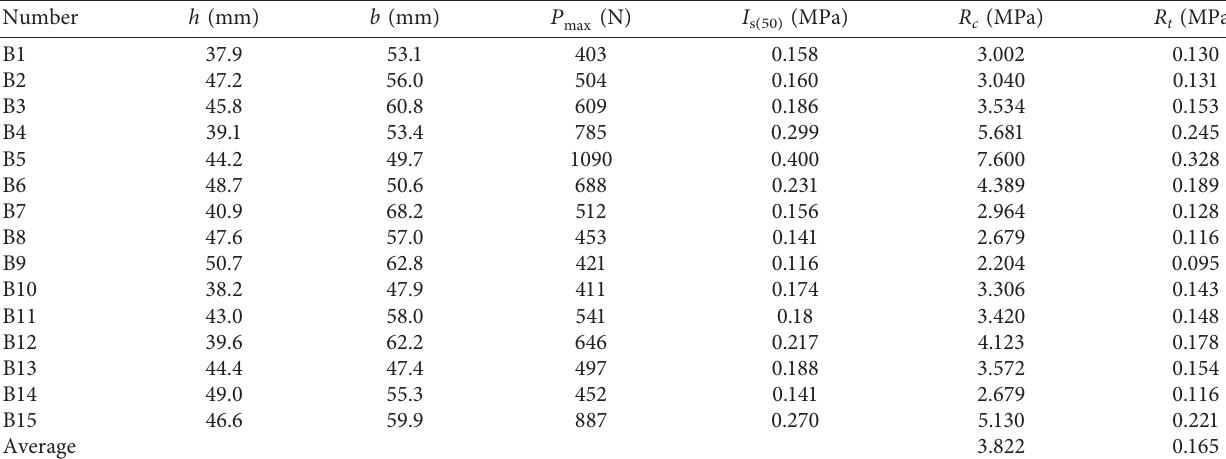
Table 2: Point-load strength of